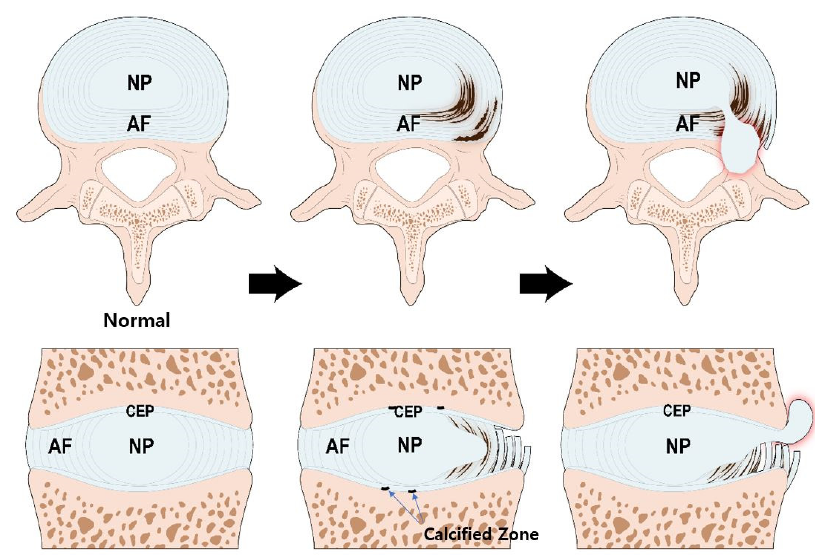
Figure 1. Structure of the IVD and pathogenesis of IVD degeneration. During the aging process, calcification occurs in the bone-cartilage junction of CEP. The calcified zone is impermeable thereby, reducing nutrient transport and inhibiting IVD cell metabolism. The NP cells, originally under adverse condition, are the first to be affected. Altered aggrecan composition and reduced type II col- lagen weakens the structural integrity of NP. Myxomatous degeneration in AF can disrupt its highly organized collagen fiber arrangement. These processes increase the potential IVD structural damage. IVD; intervertebral disc, NP; nucleus pulposus, AF; annulus fibrosus, CEP; cartilage